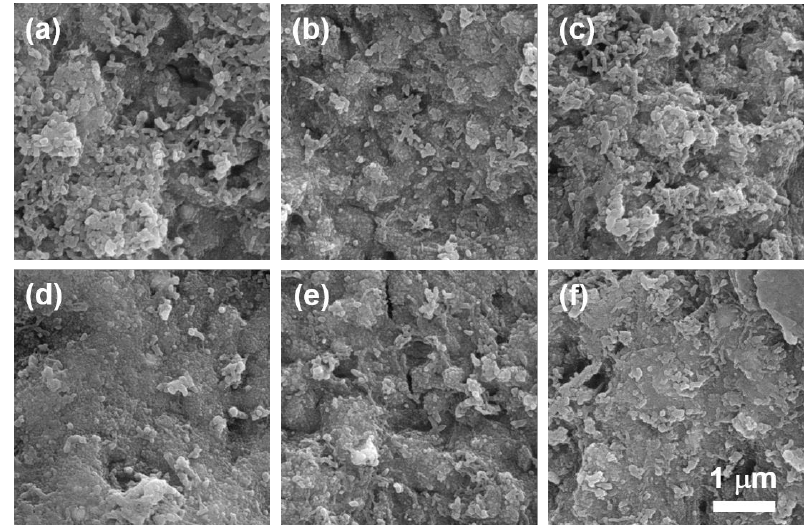
Figure 4. SEM images of the surface morphology of: ( a ) NIP-PANI before sonication; ( b ) NIP-PANI after sonication and before the exposure to PFOS; ( c ) NIP-PANI after the exposure to PFOS; ( d ) PFOS- MIP-PANI before sonication; ( e ) PFOS-MIP-PANI after sonication and before the exposure to PFOS; ( f ) PFOS-MIP-PANI after the exposure to PFOS. The scale bar denotes 1 μm in length.